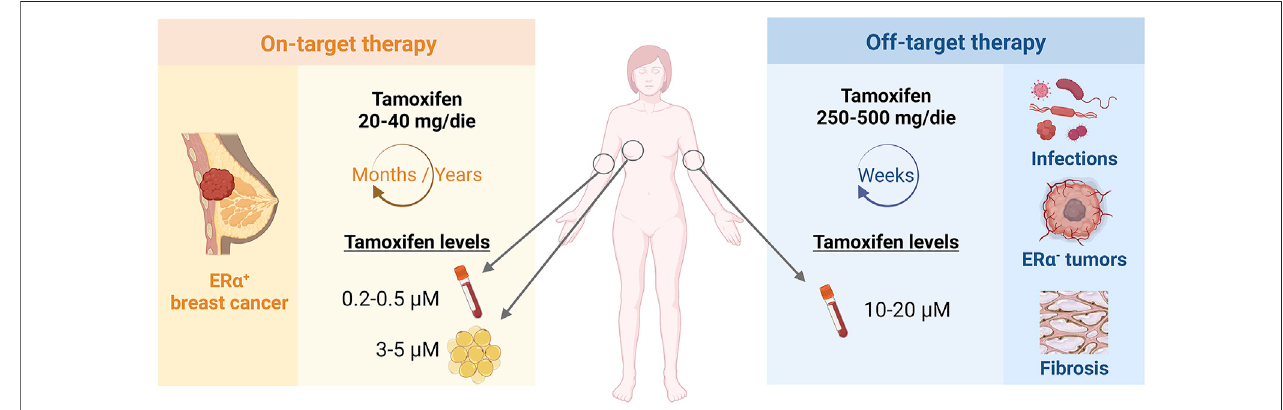
FIGURE 1 | Tamoxifen therapeutic regimen according to on- or off-target indications. Tamoxifen is administered at different concentrations and timings according to on-target, ER α -dependent or off-target, ER α -unrelated indications and may reach micromolar drug concentrations in patient plasma or tissues.